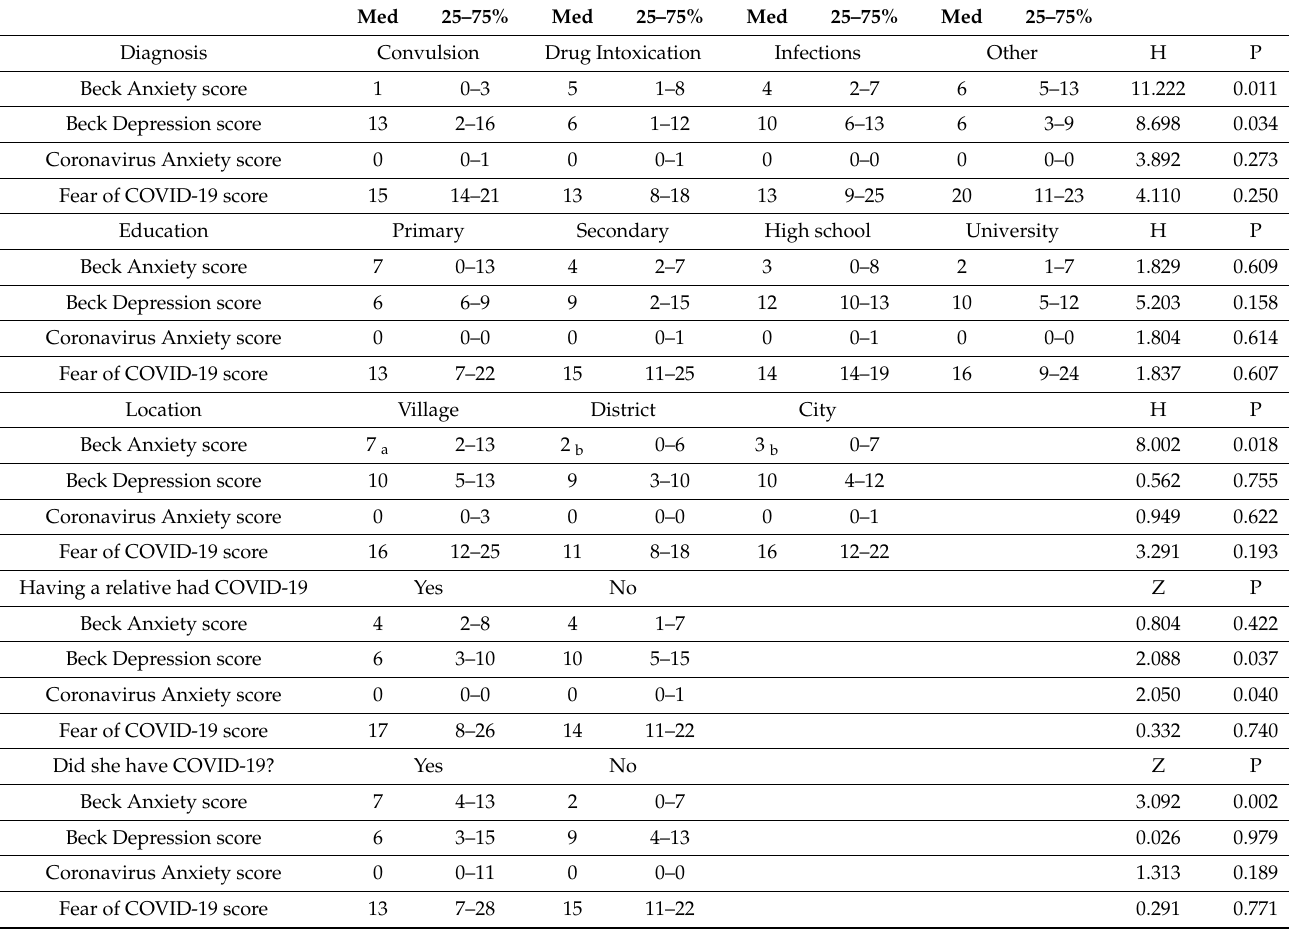
Table 2. Comparison of scale scores according to descriptive